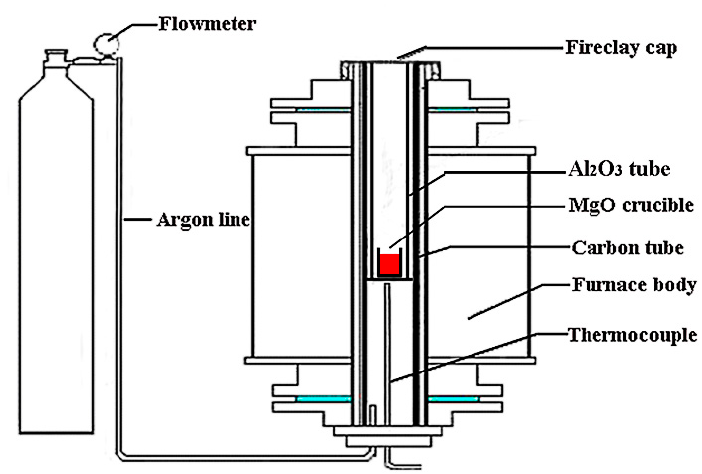
Figure 1. Schematic diagram of the graphite tube resistance furnace.